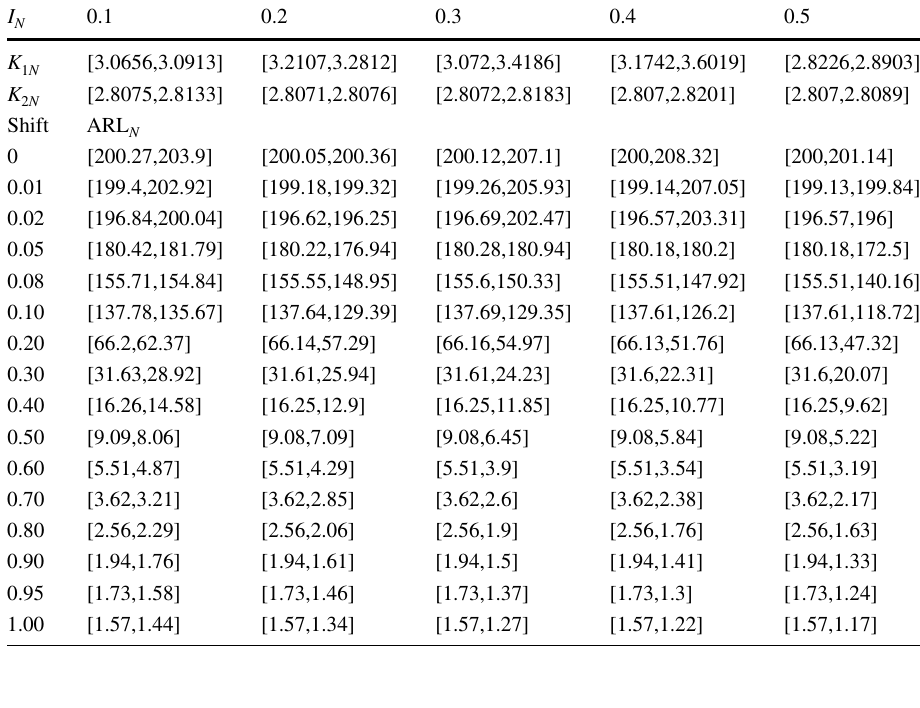
Table 3 The average run length ARL 1 values under neutrosophic statistics for n L =